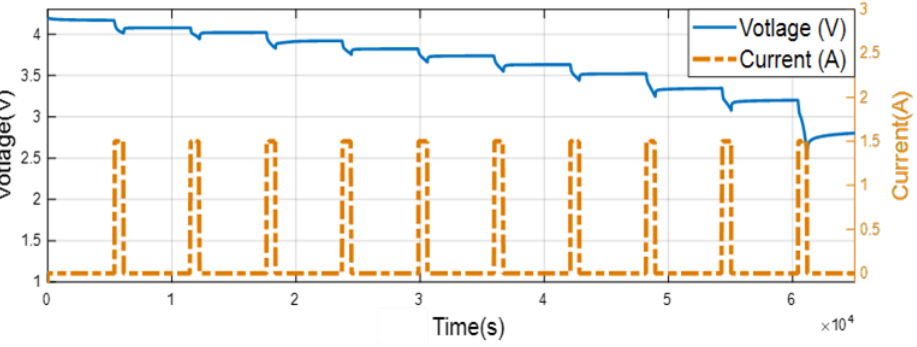
Figure 5. Voltage/current results from pulse current discharge experiment.